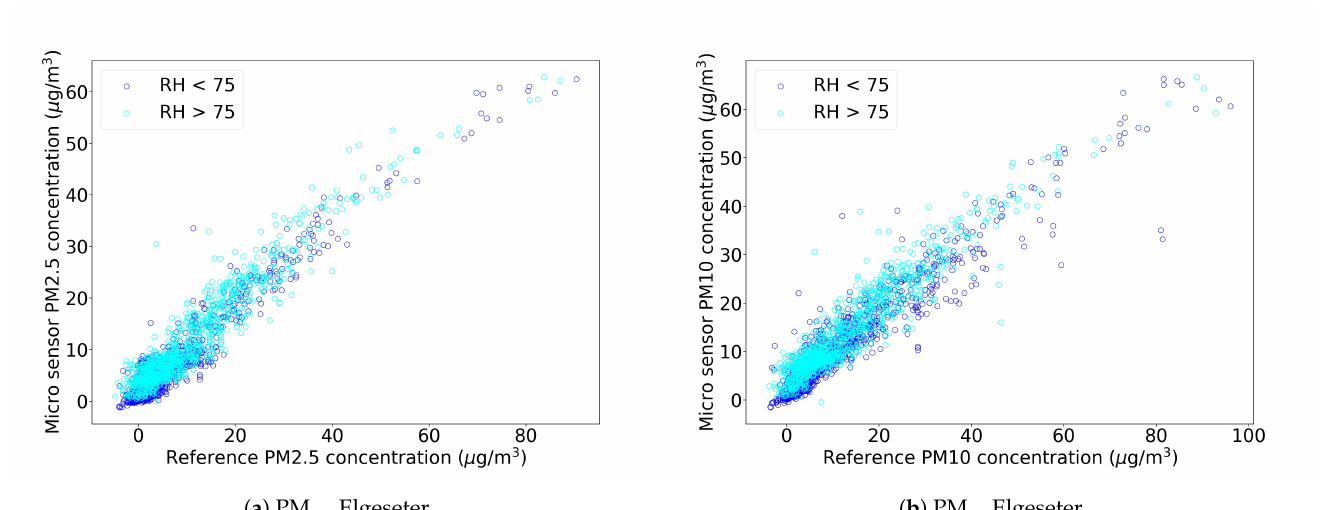
Figure 6. Scatter plots between calibrated low-cost sensor data and references. Data collected between 15 November 2020 and 23 February 2021 at Elgeseter